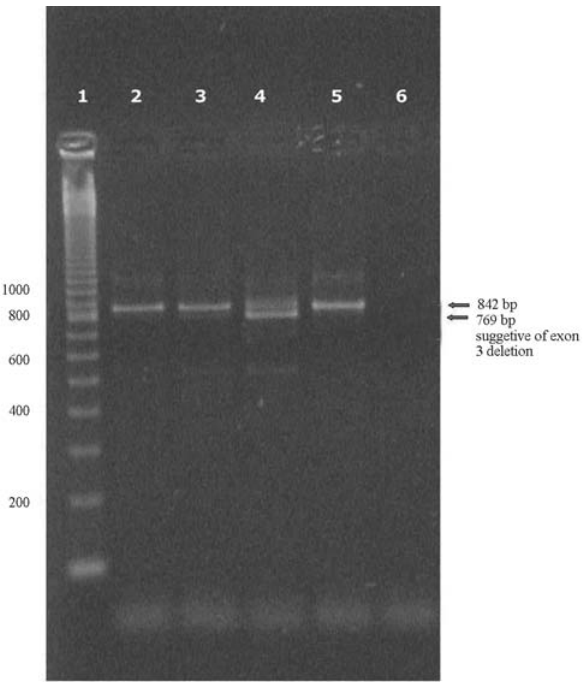
Figure 2 - cDNA analysis of exons 1 to 12 (842 bp amplification product) of the hydroxymethylbilane synthase gene. Lane 1, 100 bp DNA size marker; lane 2, normal control; lane 3, patient’s mother; lane 4, patient; lane 5, patient’s father; lane 6, negative control. The smaller product de- tected in the patient is compatible with exon 3